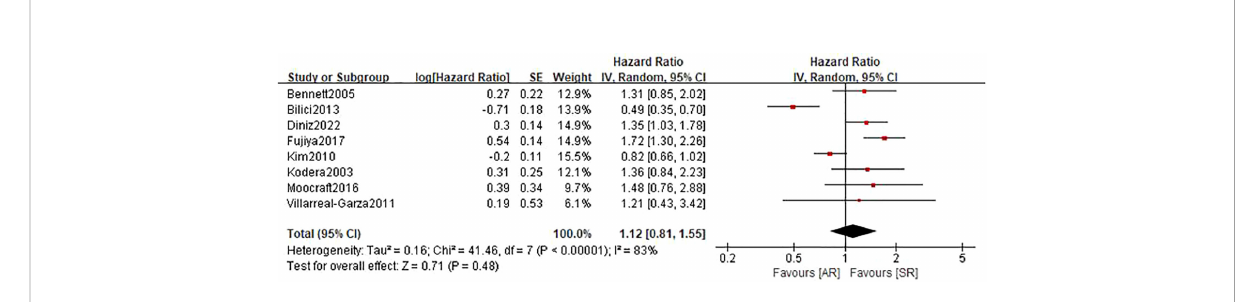
FIGURE 3 Forest plot assessing recurrence-free survival between the asymptomatic and symptomatic recurrence